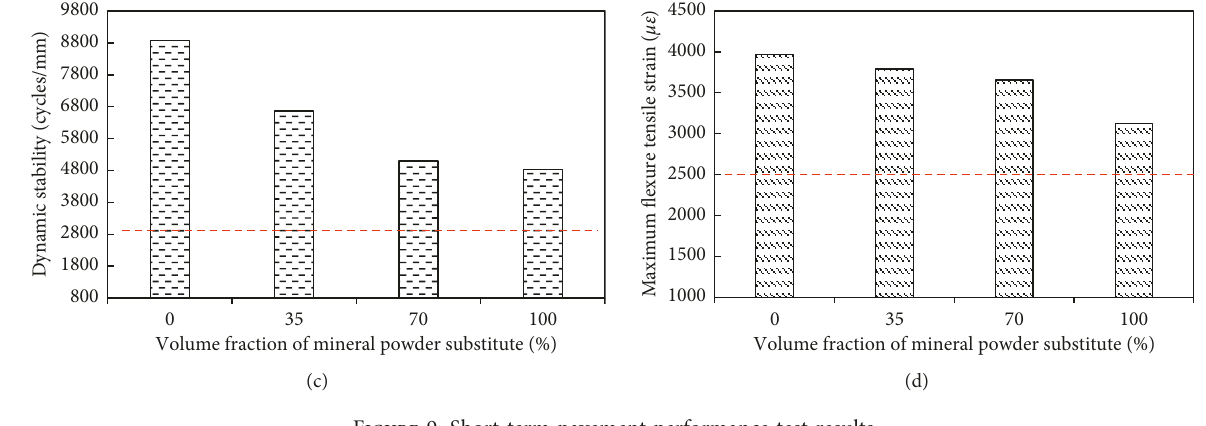
Figure 9: Short-term pavement performance test